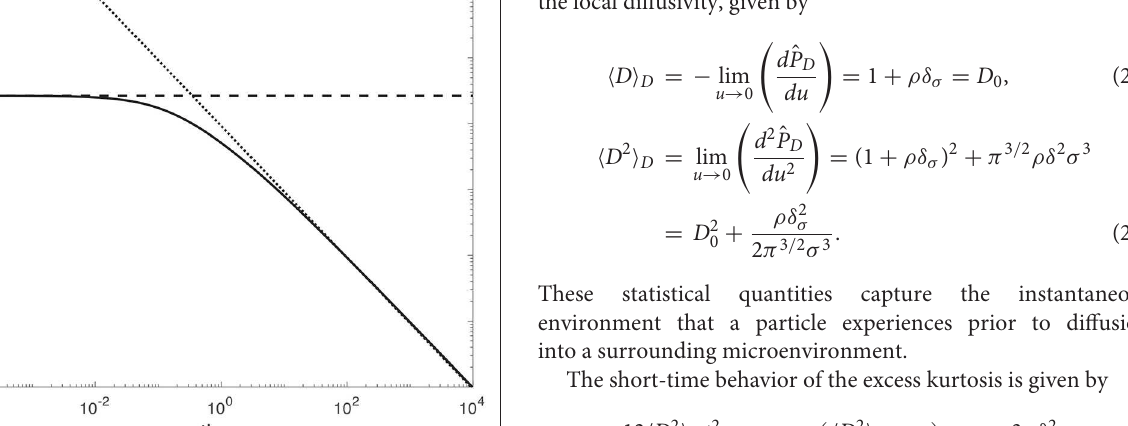
10, D 0 2, and σ 2. = = =